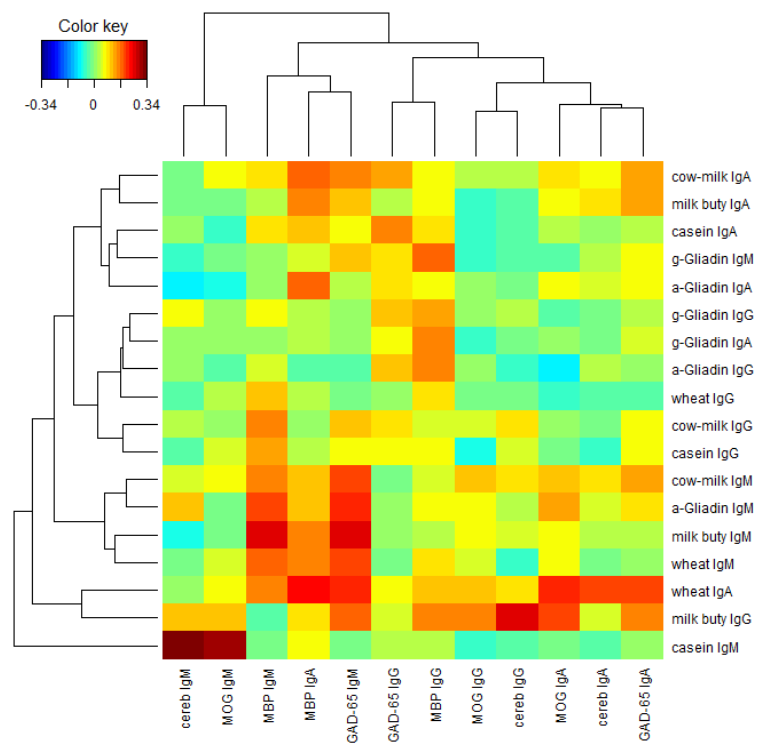
Figure 8. Two-way cluster analysis of the Pearson’s correlation coefficients between the food proteins and the brain